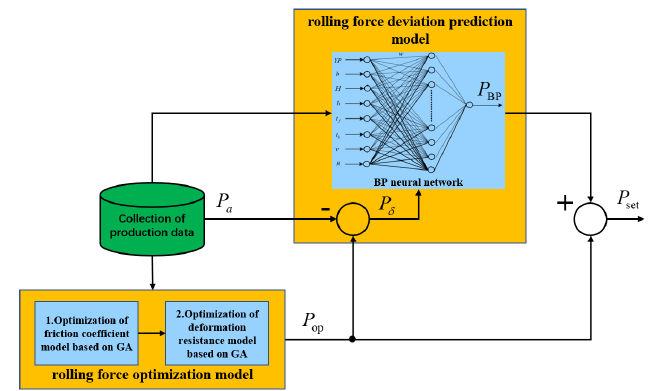
Figure 2. The calculation process of the